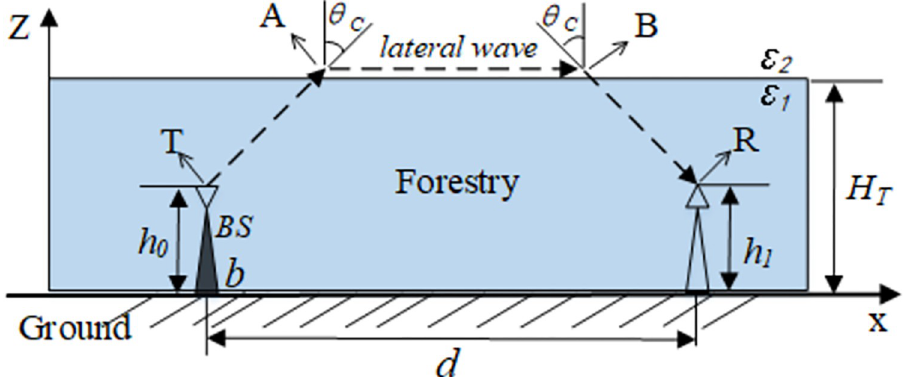
Fig 1. Vegetation signal propagation through lateral